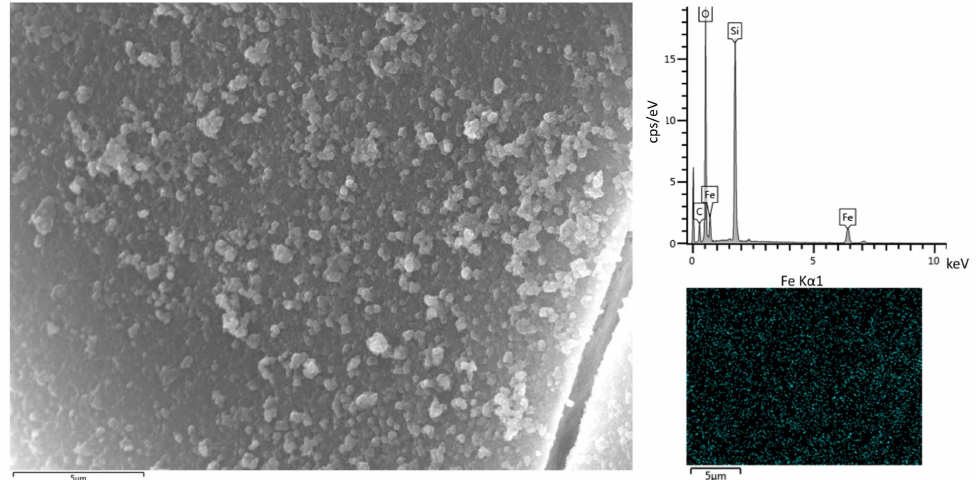
Figure 2. SEM image (5000 × magnification), EDS spectrum and EDS map (Fe, cyan) of GSP-Fe S-1. N 2 sorption tests were also conducted on